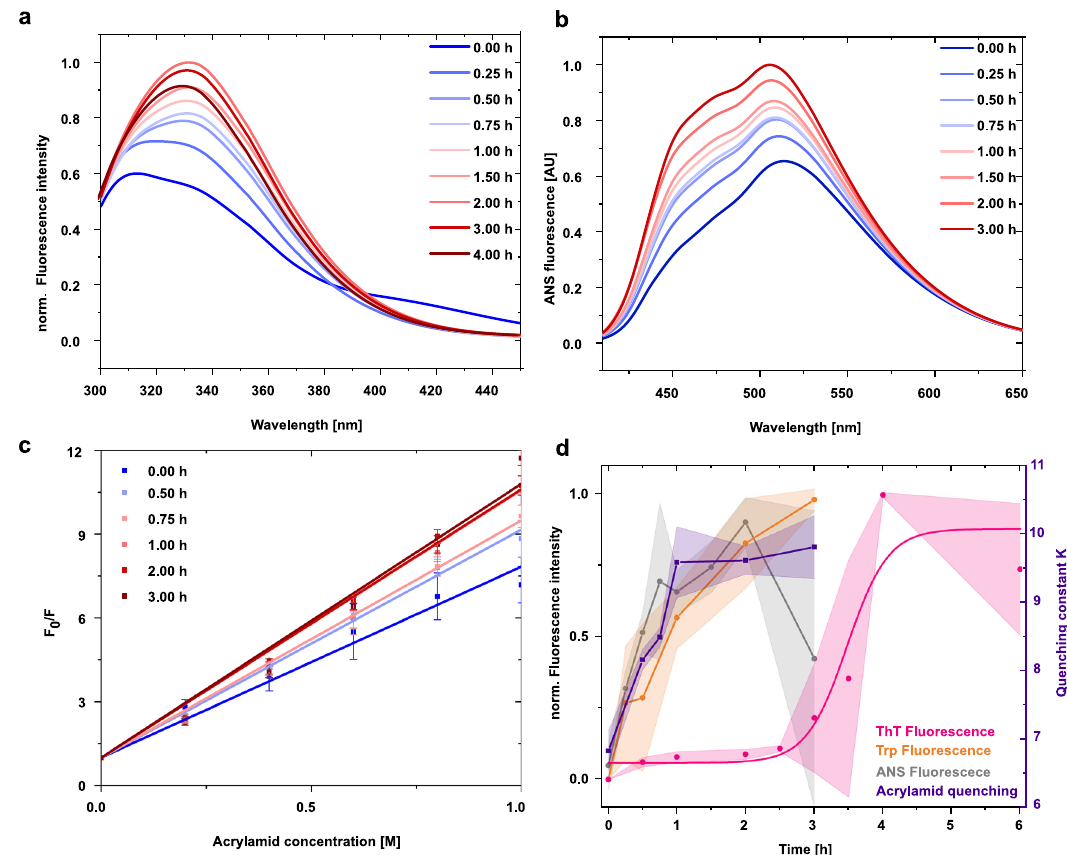
Fig. 4 Structural changes of Pat-1 during the lag phase. a Change of tryptophan fl uorescence. Each emission spectrum is the average of three individual scans. b Change of surface hydrophobicity followed by ANS fl uorescence. c Change of tryptophan fl uorescence upon quenching with 0 – 1 M acrylamide. The curves show the respective F 0 /F values of the Stern-Volmer equation, Error bars represent the SEM of n = 3. d Comparison of the normalized change of ANS fl uorescence (gray), Trp exposure (orange) and the quenching constant K of the acrylamide quenching calculated by Eq. (1) (purple) in comparison to changes in the ThT signal (pink). Shades represent the SEM of n =